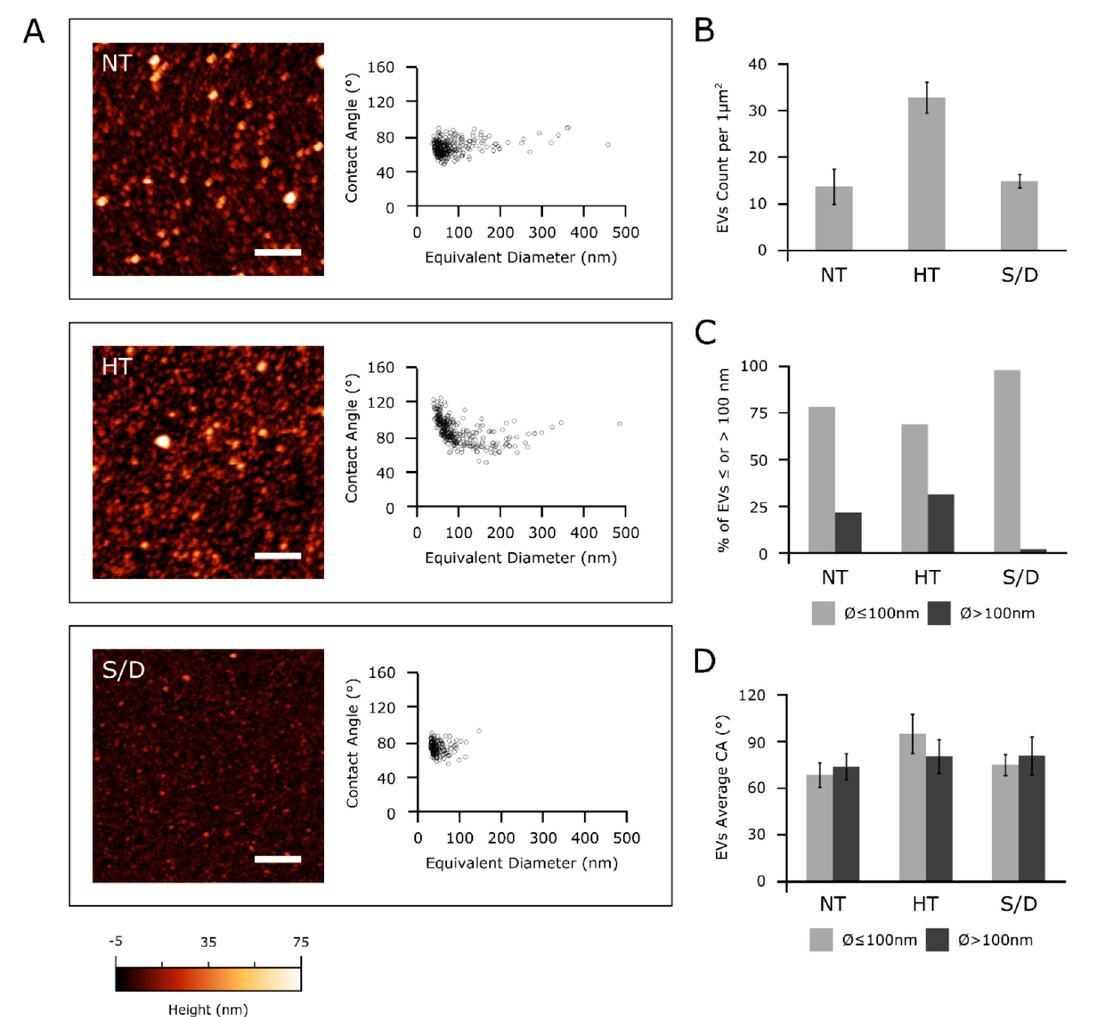
Figure 4. ( A ): left column—representative AFM micrographs of NT, HT and S/D samples. Scale bars are 1 µm. Right column—scatterplots of surface contact angle vs. diameter in solution of EVs measured via quantitative AFM morphometry as described elsewhere [8]. Each circle represents an individual EV. ( B ): surface density of globular objects in NT, HT and S/D samples deposited with the same protocol (see Experimental Section); ( C ) percentage of adsorbed EVs having diameters above or below 100 nm in their spherical conformation; ( D ) average surface/vesicle contact angle (representative of mechanical stiffness) of EVs with diameters above or below 100 nm.